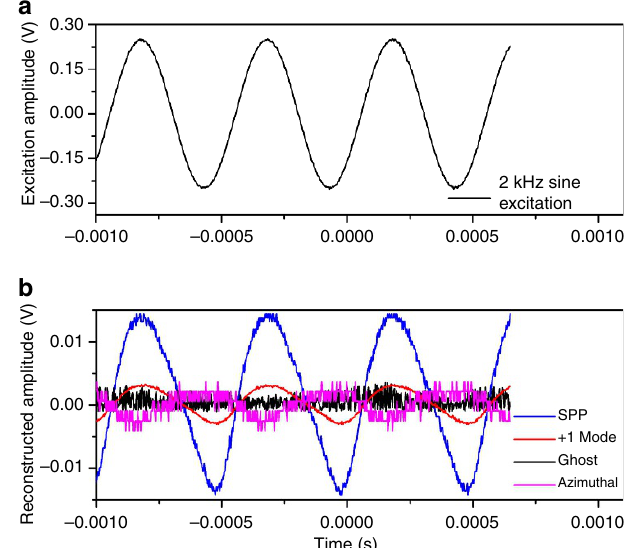
Figure 7 | Sensor response to an acoustic wave. ( a ) The waveform of the 2kHz sine wave excitation source for the sound wave. ( b ) The photodetector measurement of the transmitted power when a single- wavelength tunable laser source is lined-up on the edge of several selected resonances: SPP phase-matched mode at 1,316.382nm (blue curve), nearest neighbour mode at 1,318.184nm (red curve), ghost mode at 1,542.288nm (black curve) and S-polarized mode closest to the SPP at 1,317.024nm (magenta curve).